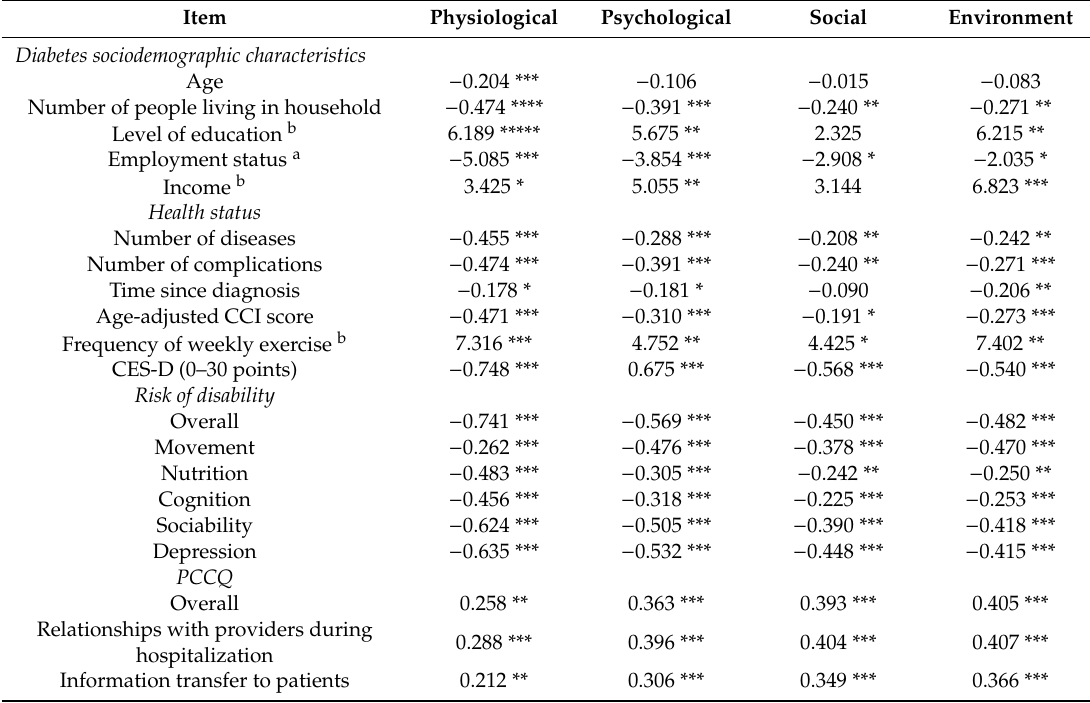
Table 2. Correlation between sociodemographic characteristics, health status, risk of disability, patient continuity of care, and quality of life among patients with type 2 diabetes ( N =